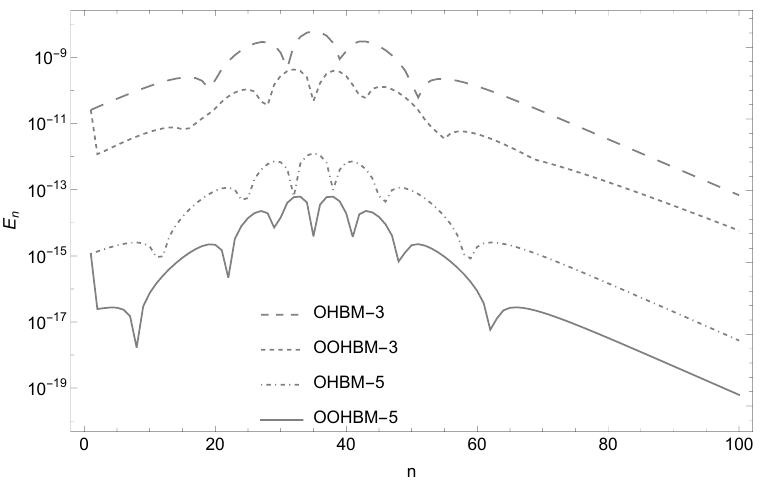
Figure 6. Maximum error profile for Example